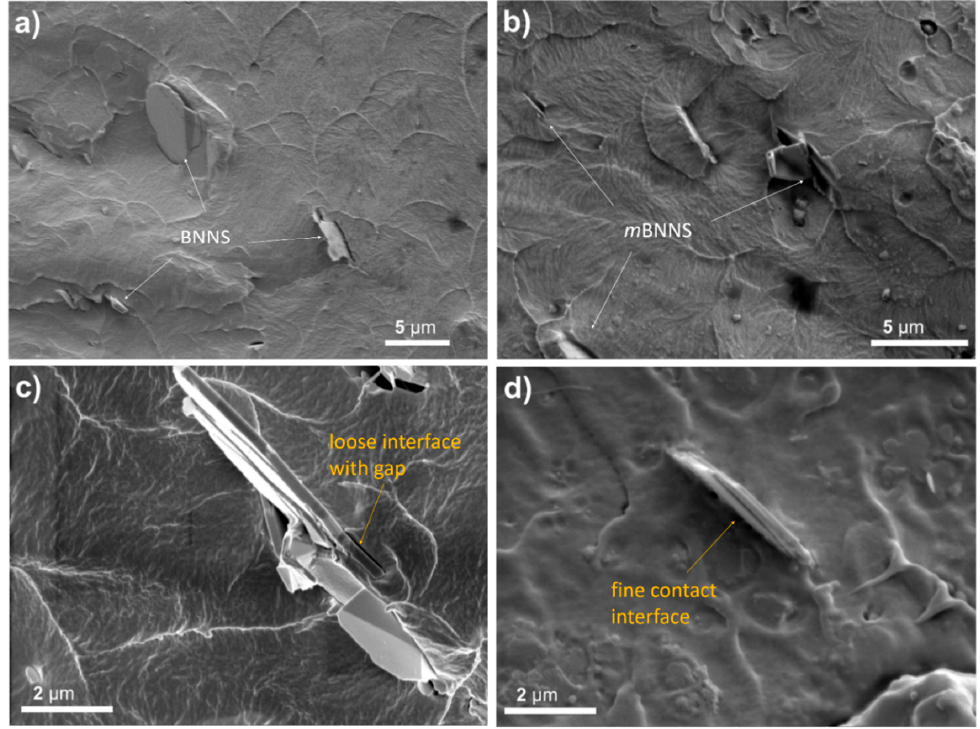
Figure 5. Cross-sectional scanning electron microscopy (SEM) images of the composite films containing 6 wt% ( a , c ) BNNS and ( b , d ) m BNNS particles.